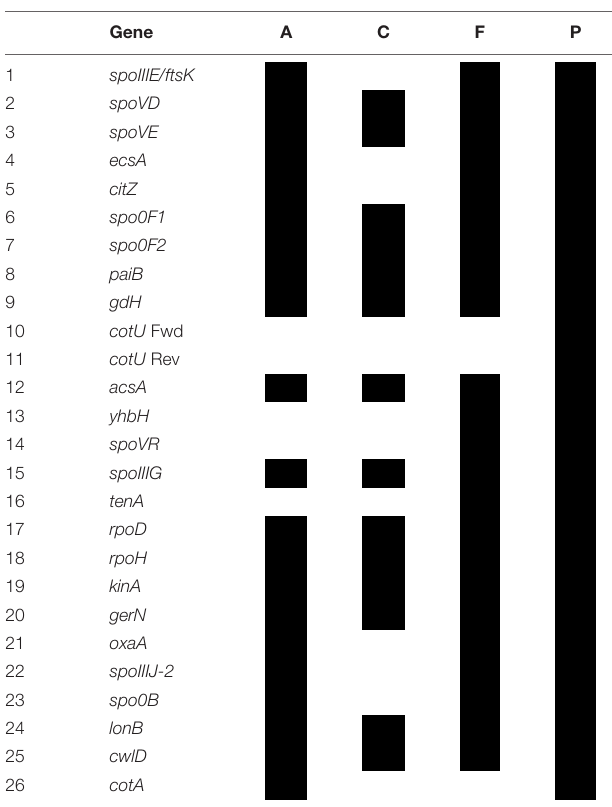
TABLE 1 | Presence of the 26 genes detected in the genome of Serratia in multiple